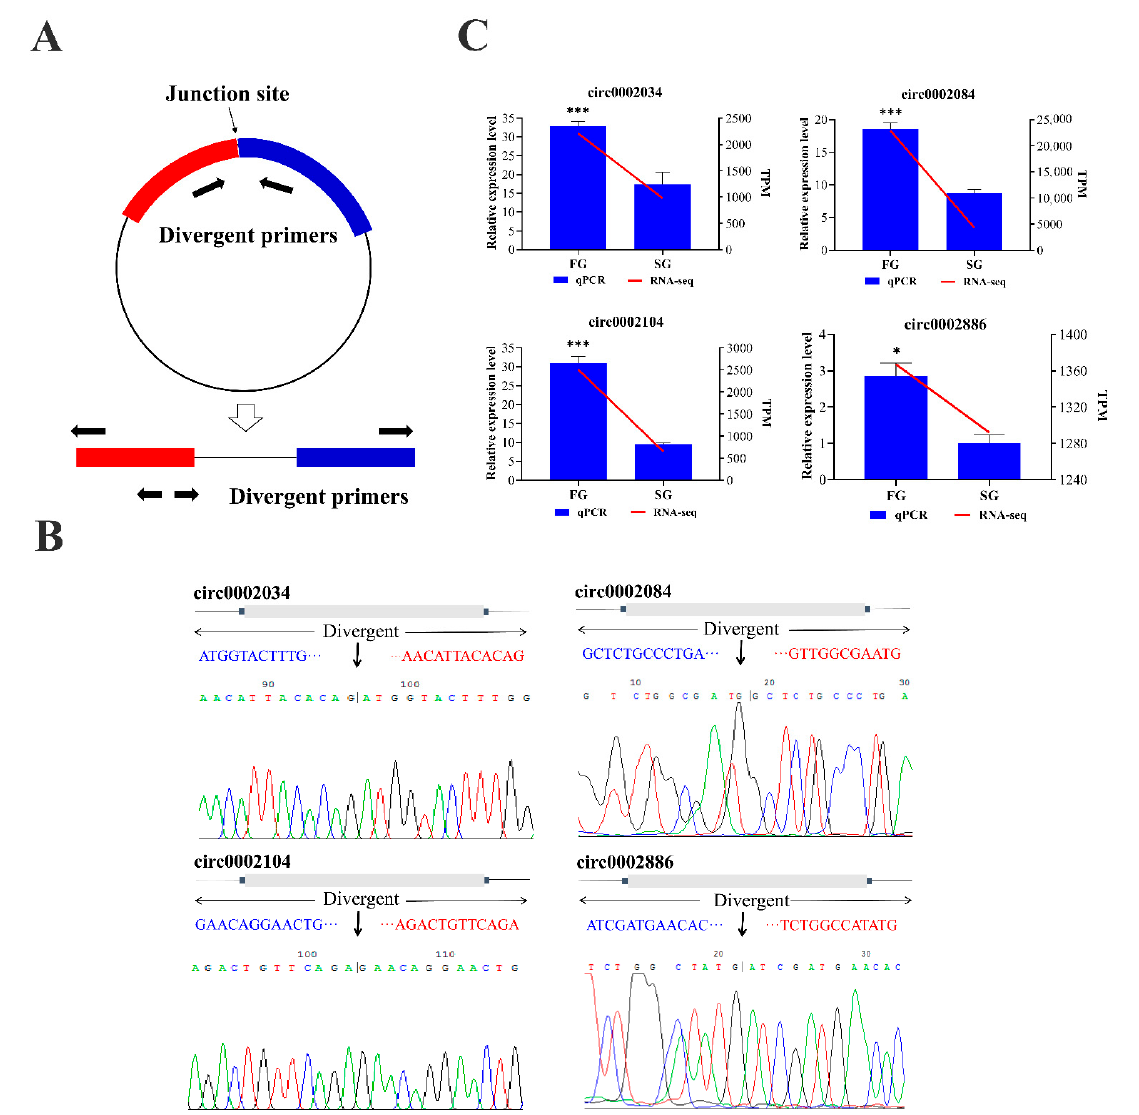
Figure 7. Validation of circRNAs identified from the M. amblycephala . ( A ) Schematic view illustrating the design of primers for circRNAs used in qPCR. ( B ) Representative examples of PCR products sequenced to confirm circRNA junction sequences. ( C ) Validation of circRNAs by qPCR. Note: Error bars represent SE of expression. * on the bars indicate p < 0.05 and *** indicate p < 0.001 between FG and SG groups (ANOVA followed by Tukey test, n = 3 for each group).